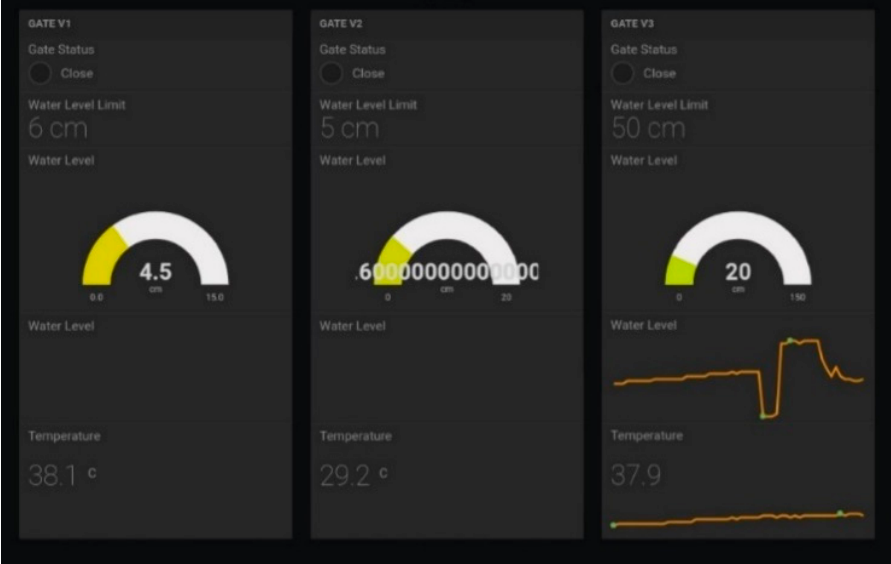
Figure 20. 1/3 of data completion from the IoT Client. Figure 20. 1 / 3 of data completion from the IoT